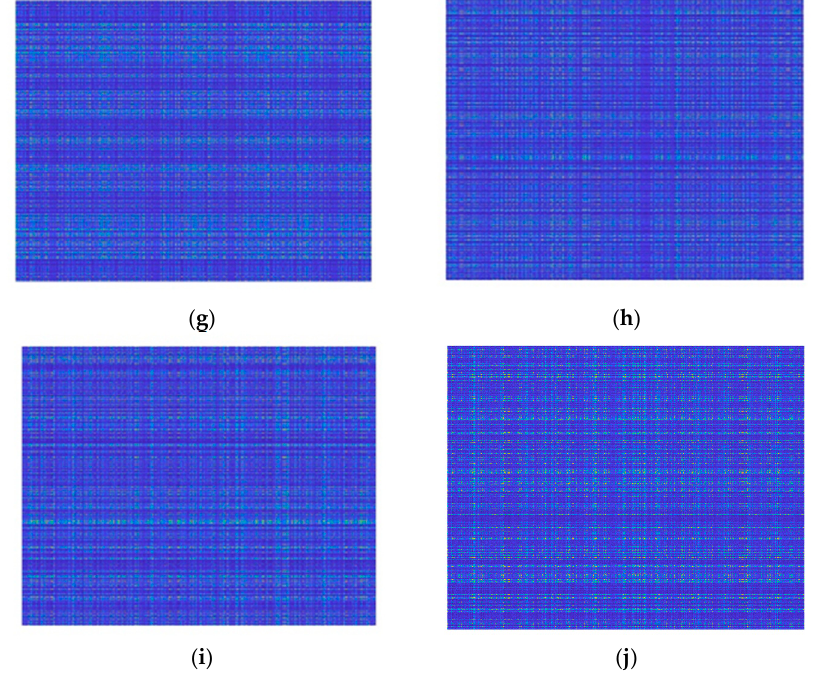
Figure 10. Ten confused DEM B. Their histograms are the same.